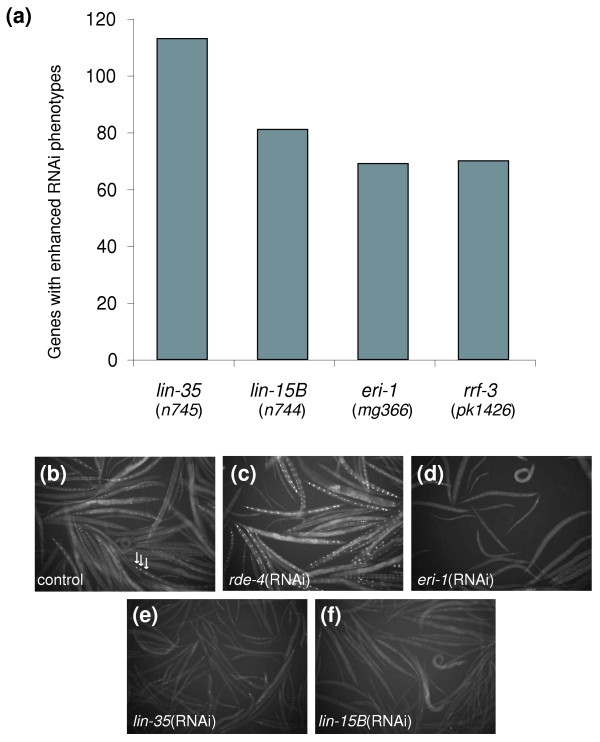
Inactivation of lin-35 or lin-15B enhances RNAi. (a) The number of genes with enhanced RNAi phenotypes in the worm strains lin-35(n745), lin-15B(n744), eri-1(mg366) and rrf-3(pk1426). The chart shows the number of genes with RNAi phenotypes that are significantly stronger in each strain than in wild-type (Bristol N2) worms. A total of 1,838 bacterial RNAi feeding strains from the Ahringer library [4] targeting 1,749 genes were tested with each worm strain. (b-f) RNAi-induced silencing of lin-35 or lin-15B enhances the dsRNA-induced silencing of a GFP transgene. Worm strain GR1401 expresses an integrated GFP transgene and a dsRNA that targets GFP mRNA for degradation, both expressed specifically in the hypodermal seam cells of the worm (arrows) [9]. (b) Control experiments used a feeding strain that does not target any C. elegans gene and causes no change in the silencing of GFP. dsRNA targeting components of the RNAi machinery such as (c) rde-4 suppress the silencing of GFP, whereas dsRNAs targeting (d) eri-1, (e) lin-35 or (f) lin-15B result in enhanced silencing of GFP. See Table 2 for quantification of this data.